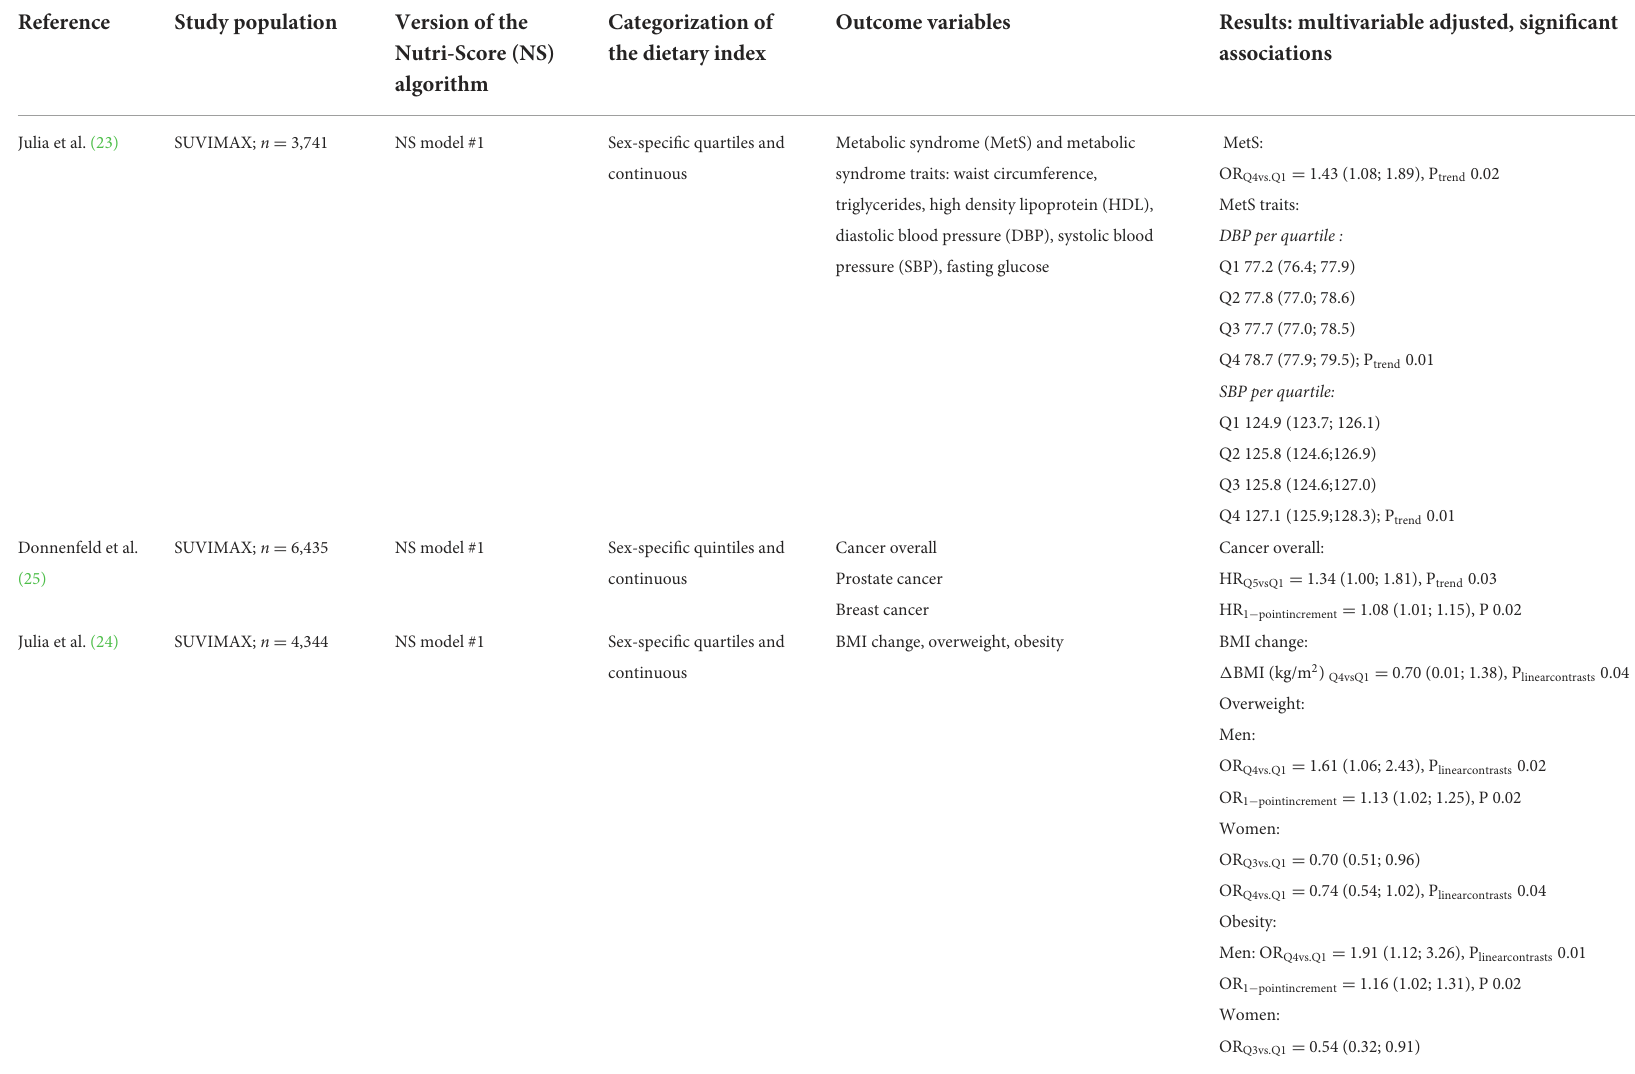
TABLE 4 Results of predictive validity studies for the Nutri-Score algorithm in the French context: multivariable associations of the Nutri-Score dietary index with overweight, obesity and metabolic syndrome [odds ratios (OR) with 95% confidence intervals] and with cardiovascular disease risk, cancer risk and mortality [hazard ratios (HR) with 95% confidence